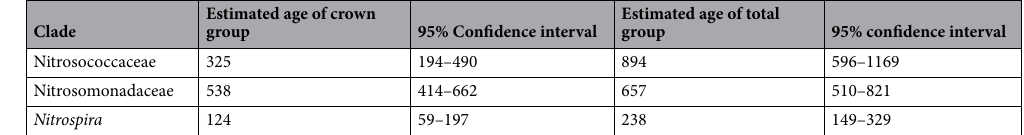
Estimated age of crown group 95% Confidence interval